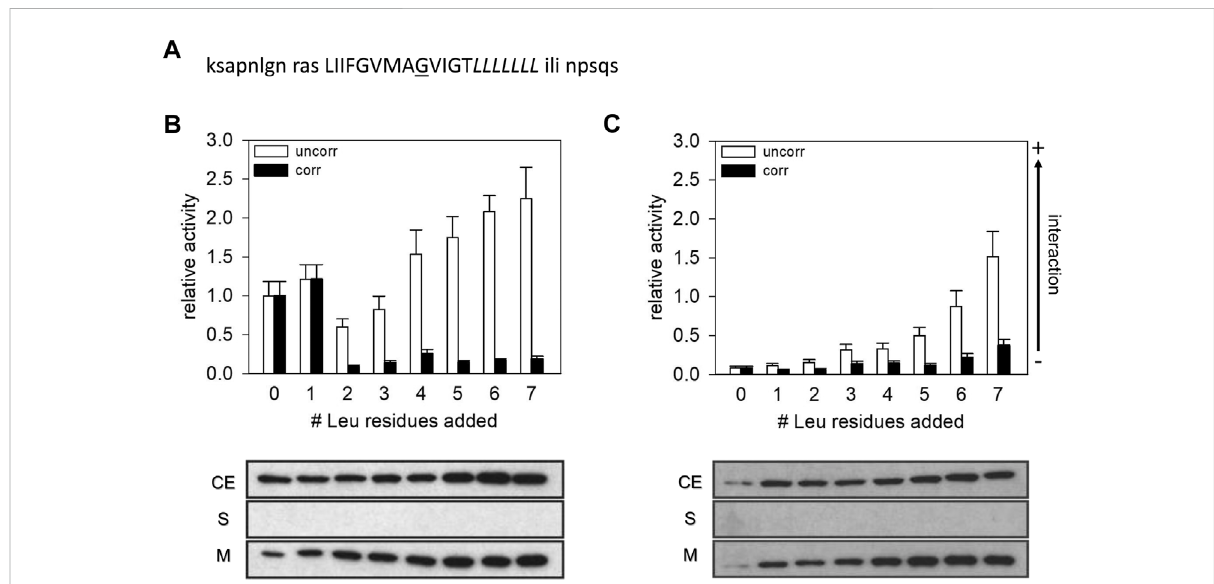
FIGURE 1 CATactivitiesmeasuredwiththeconstructexpressingtheGpA13wtandGpA_G83ITMdomain. (A) SequenceoftheGpATMdomainexpressed from the TOXCAT plasmid pccGpA wt and G83I. The Leu residues indicated in italics were successively added at the GpA TM helix ’ C-terminus. The residue G83, which was mutated to Ile, is underlined. Residues, fl anking the TM helix and which were introduced by the plasmids, are shown in low- caseletters. (B,C) CATactivitiesofGpAwt (B) andGpAG83I (C) measuredwiththeTOXCATsystem.Themeasuredactivitieswerenormalizedto the activity of the wt GpA13 fusion protein. White bars: uncorrected data. Black bars: Activities corrected for differences in protein expression levels. Lowerpanel:Expressionlevelandsubcellularlocalizationofthefusionproteins.Samplesfrom E.coli cellularextract(CE),solubleproteinfractions(S) and membranes (M) were analyzed via Western blots using an anti-MalE